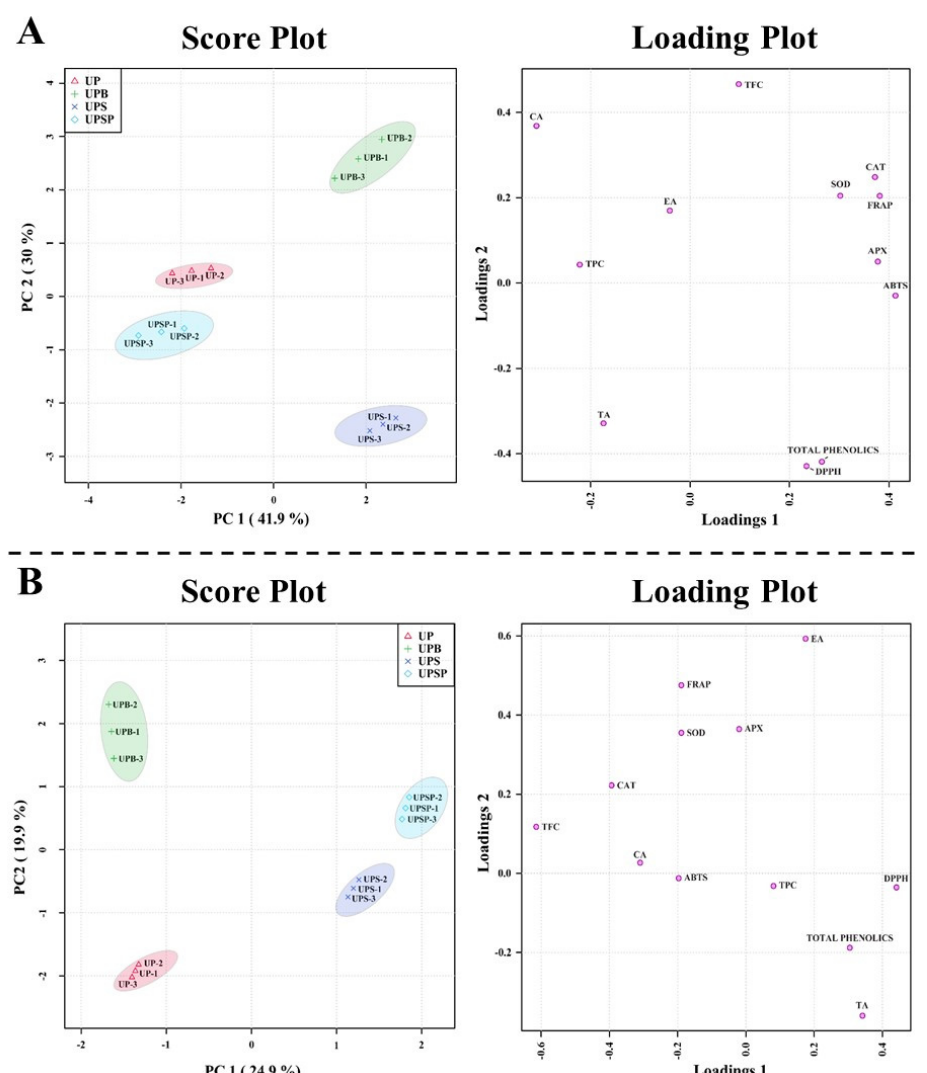
Figure 3. Score and loading plot of ( A ) PCA model and ( B ) PLS-DA model acquired from the metabolites detected from different parts of Undaria pinnatifida . Note: ABTS, ABTS radical scavenging activity; APX, ascorbate peroxidase activity; CA, collagenase inhibitory activities; CAT, catalase activity; DPPH, DPPH radical scavenging activity; EA, elastase inhibitory activities; FRAP value, ferric reducing antioxidant power value; SOD, superoxide dismutase activity; TA, tyrosinase inhibitory activity; TFC, total flavonoid content; and TPC, total polyphenol